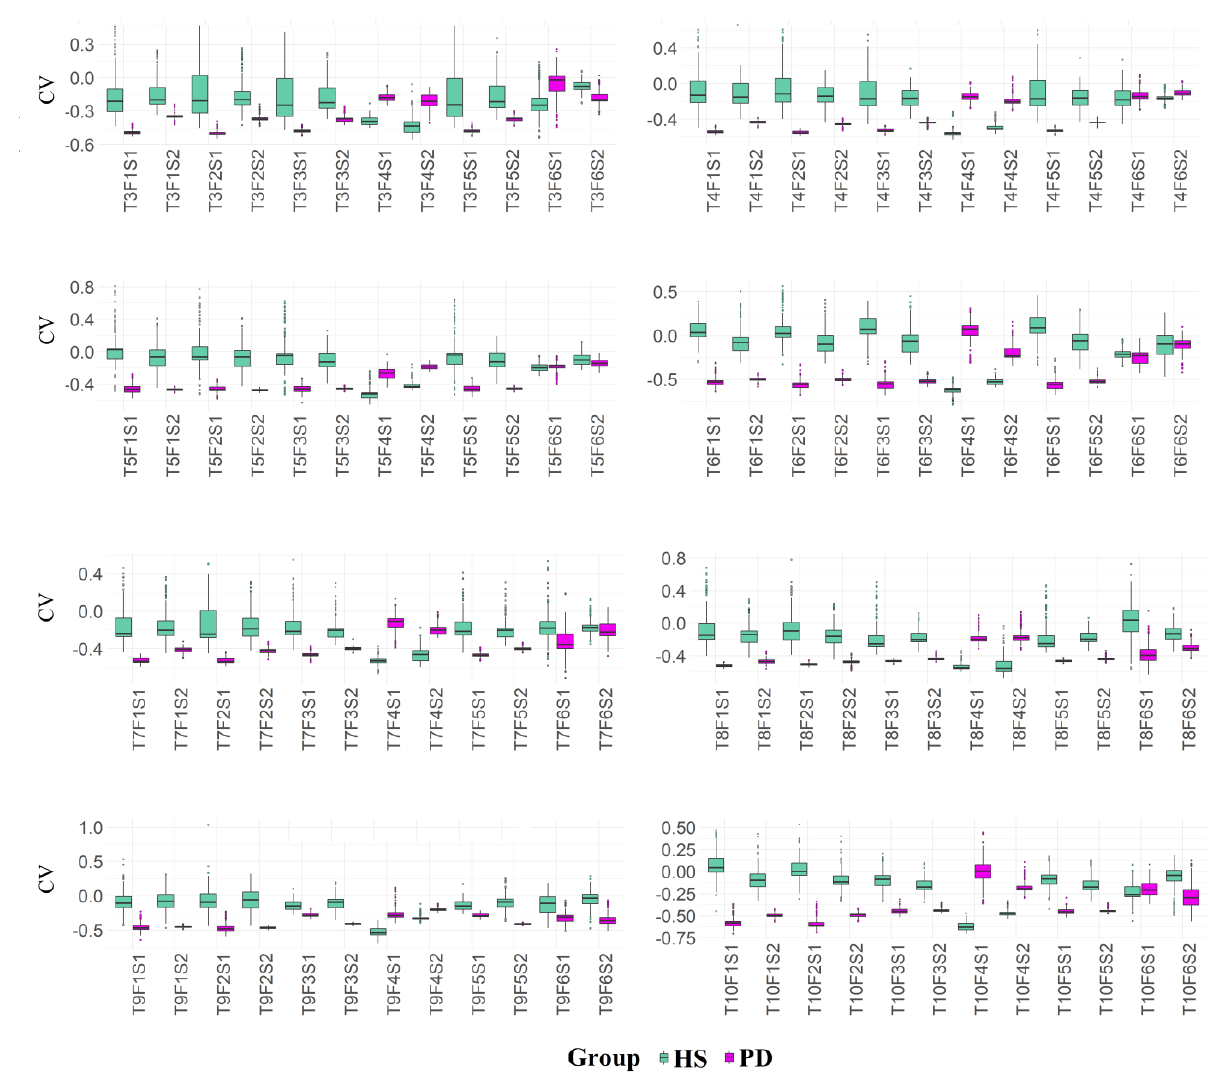
Figure 8. Coefficient of variation estimated for each variable and group (HS and PD). The estimates are based on 1000 Bootstrap samples.